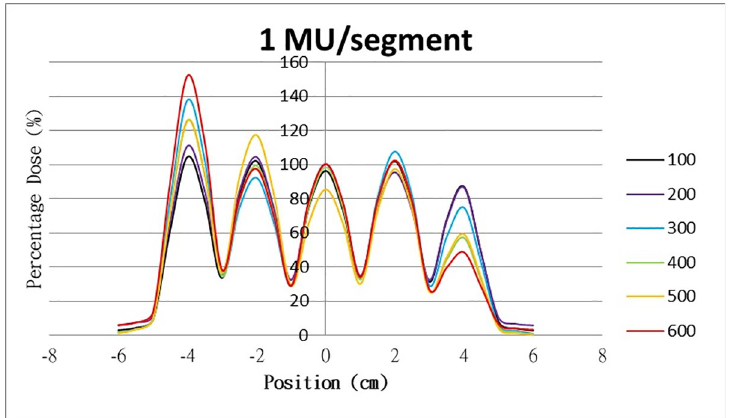
Fig 6. Overshoot effect measured at various MU values and dose rates. Overshoot effect, at various dose rates, for (6) 1 MU, (7) 2 MU, (8) 3 MU, (9) 4 MU, (10) 5 MU, (11) 6 MU, (12) 7 MU, (13) 8 MU, (14) 9 MU, (15) and 10 MU.